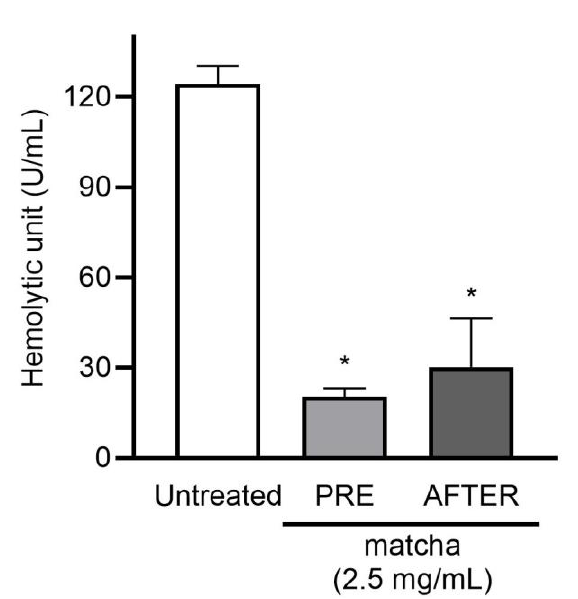
Figure A1. Hemolysis activity of bacteria supernatants. S. pneumoniae strain D39 was grown in the presence (PRE) or absence (untreated) of matcha supernatants (0 or 2.5 mg/mL) until reaching the OD 600 = 0.6. Additionally, the bacterial supernatant from the untreated group was incubated with the matcha supernatant (2.5 mg/mL: AFTER) at 37 ◦ C for 1 h. Thereafter, the hemolytic activity of each sample was determined. Data are shown as the mean ± SD ( n = 3 per group), and were evaluated using one-way analysis of Dunnett’s multiple-comparisons test, * p < 0.05 versus the untreated group.